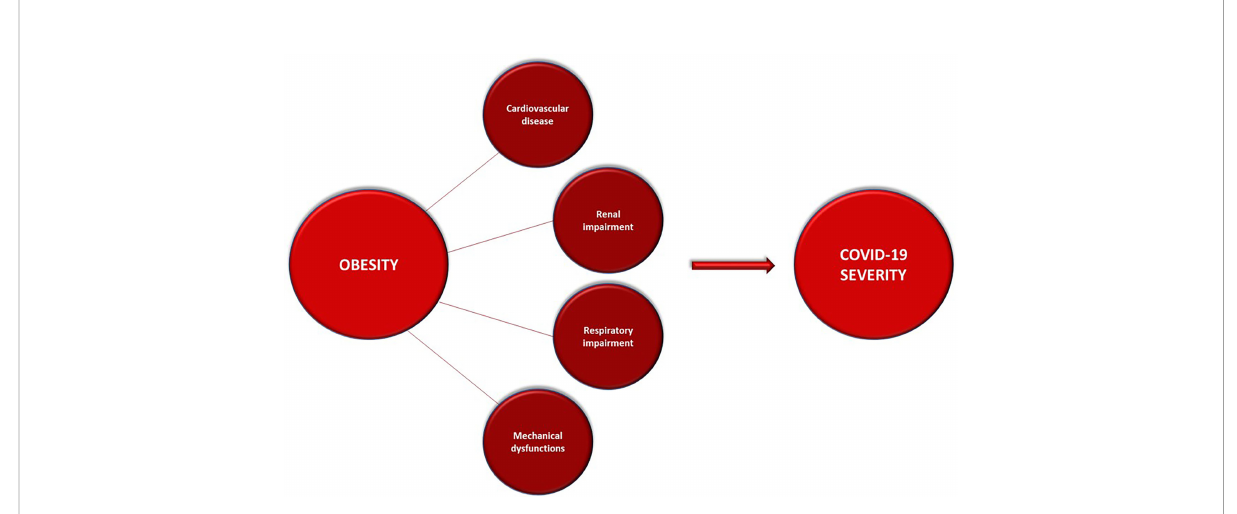
FIGURE 4 Obesity-related clinical complications that can underly and worsen the course of COVID-19.